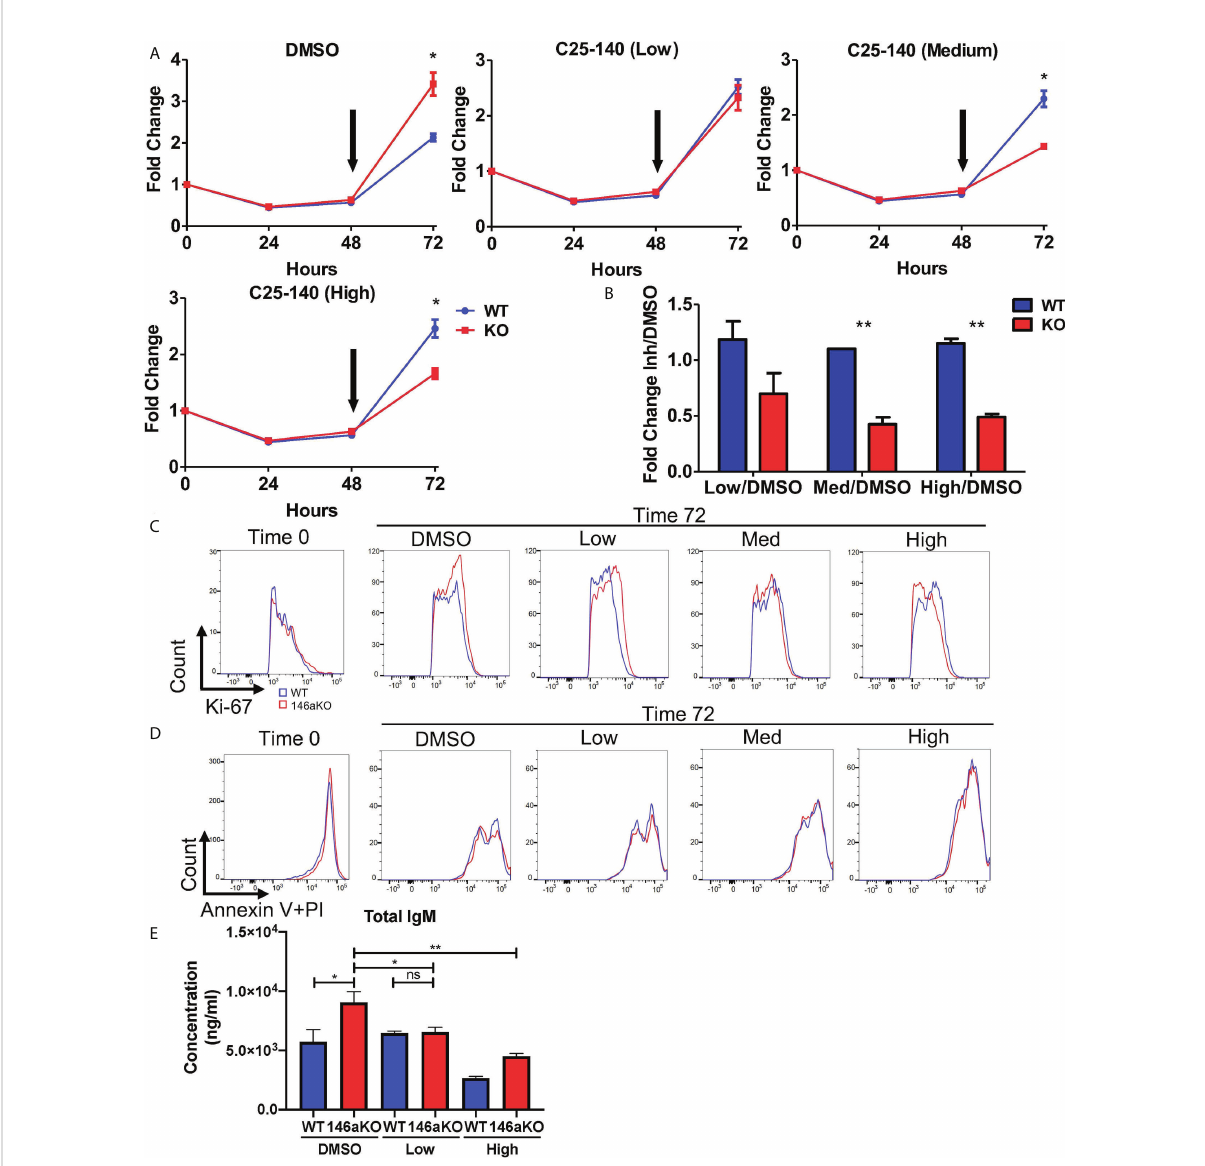
FIGURE 6 Pharmaceutical direct TRAF6 inhibition leads to graded decrease of miR-146a mediated B-cell proliferative response. (A) miR-146aKO splenic B- cells were stimulated with LPS, and TRAF6 inhibitor compound, C25-140 (5uM low dose; 15um medium dose; 30-40uM high dose), was added at 48 hours (black arrow) to assess the effects of cell count at 72 hours. Representative of 4-8 mice/group in duplicates, con fi rmed in three independent experiments. (B) Analysis of cellular response at 72 hours showed C25-140 inhibitor affecting KO cells greater than WT. All analysis used t test for respective time point comparisons. (C) Corresponding FACS analysis showed higher KO vs. WT Ki-67 proliferation at 72hrs in control group, which is reversed with dose dependent inhibitor addition. (D) Annexin V with propidium iodide staining showed no differences between WT and KO groups at 72hrs. (E) Supernatants from in vitro stimulation with TRAF6 inhibition at 72hr show a reduction in total IgM secretion in miR-146aKO B cells. *P < 0.05; **P < 0.01; ns, non-signi fi